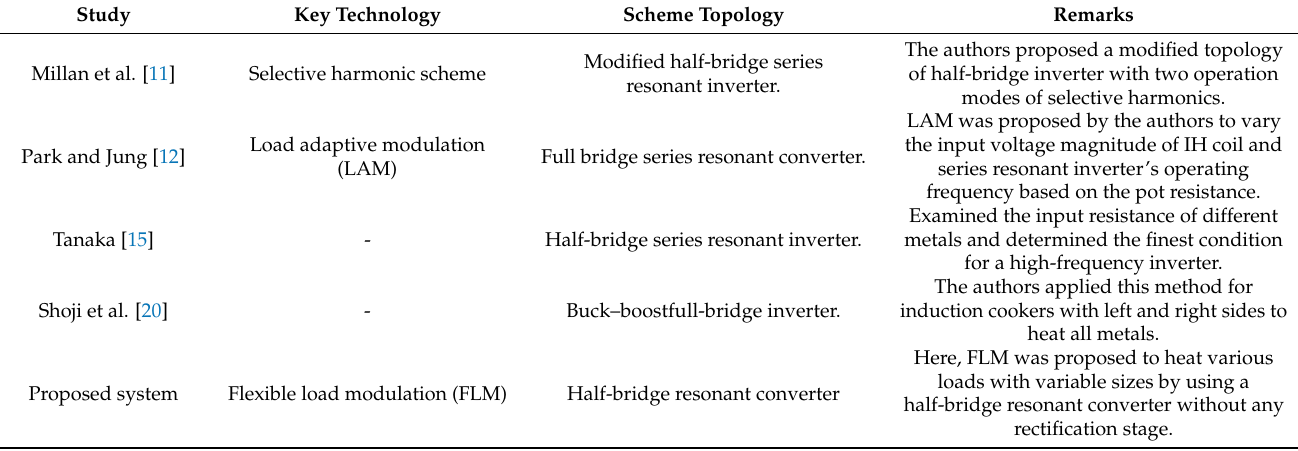
Table 4. Comparison of different variable-load induction heating